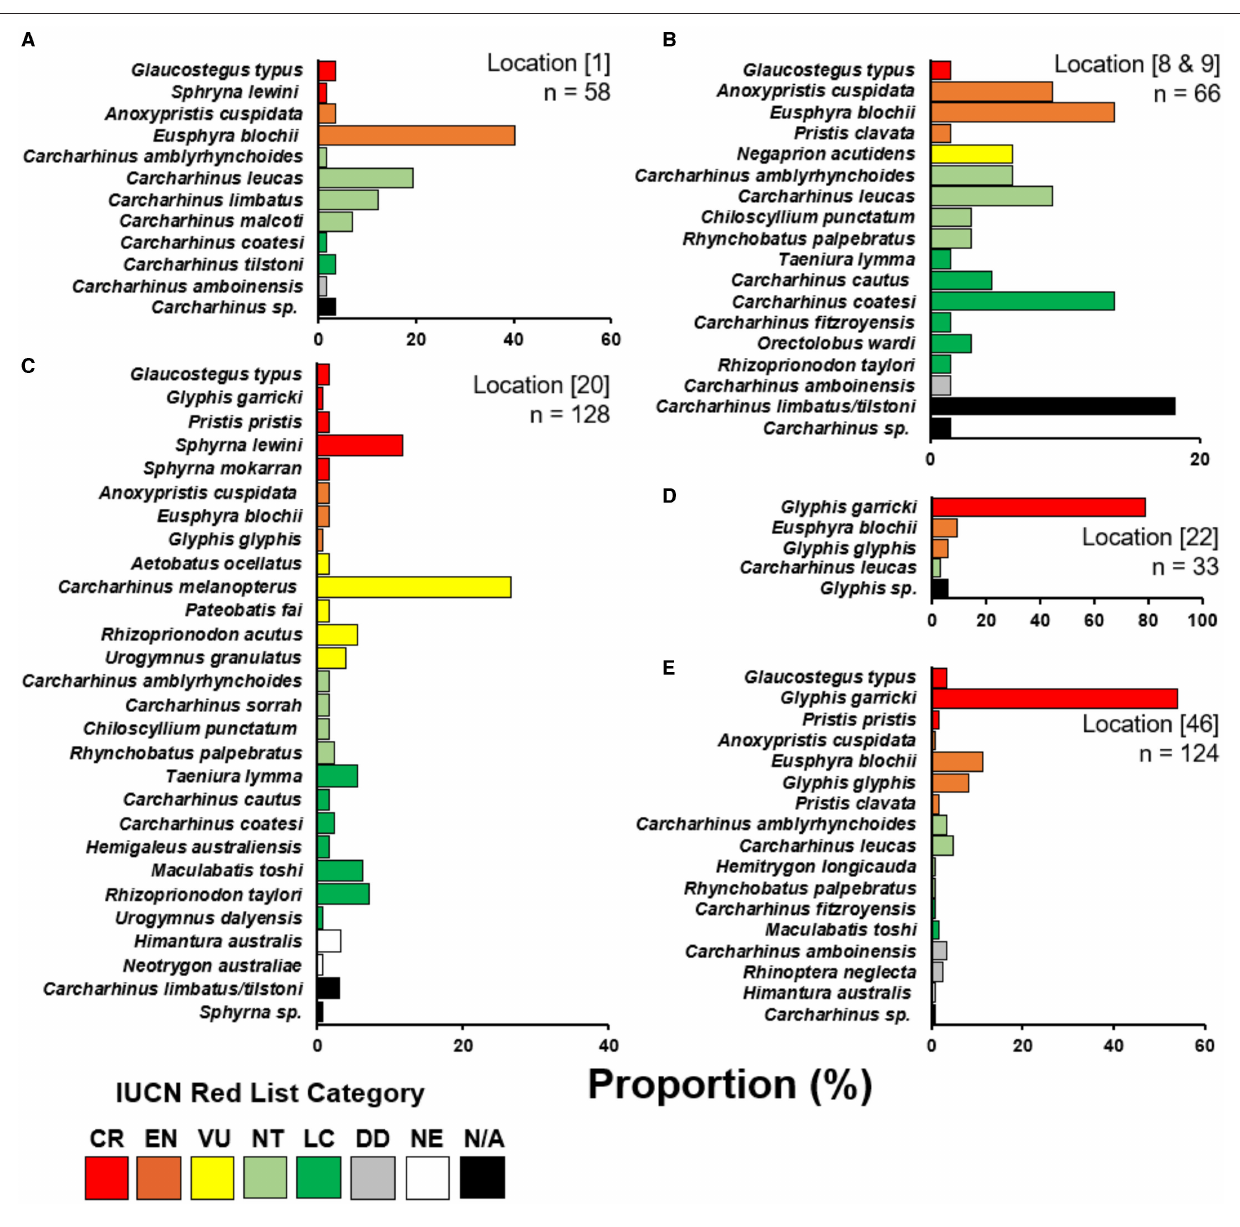
FIGURE 3 | Species composition of enumerator recorded catch. (A) Kopar Village, Sepik River; (B) Sibidiri and Buzi Village combined, Mia Kussa River; (C) Katatai Village, South Fly Coast; (D) Nemadabu fishing camp, Fly River; and, (E) Goare Village, Kikori River. Location numbers from Figure 1 are provided in square parentheses with number of specimens ( n ) observed by each enumerator. Species are categorized into their current IUCN Red List category (IUCN 2021). CR, critically endangered; EN, endangered; VU, vulnerable; NT, near threatened; LC, least concern; DD, data deficient; NE, not evaluated; N/A, not